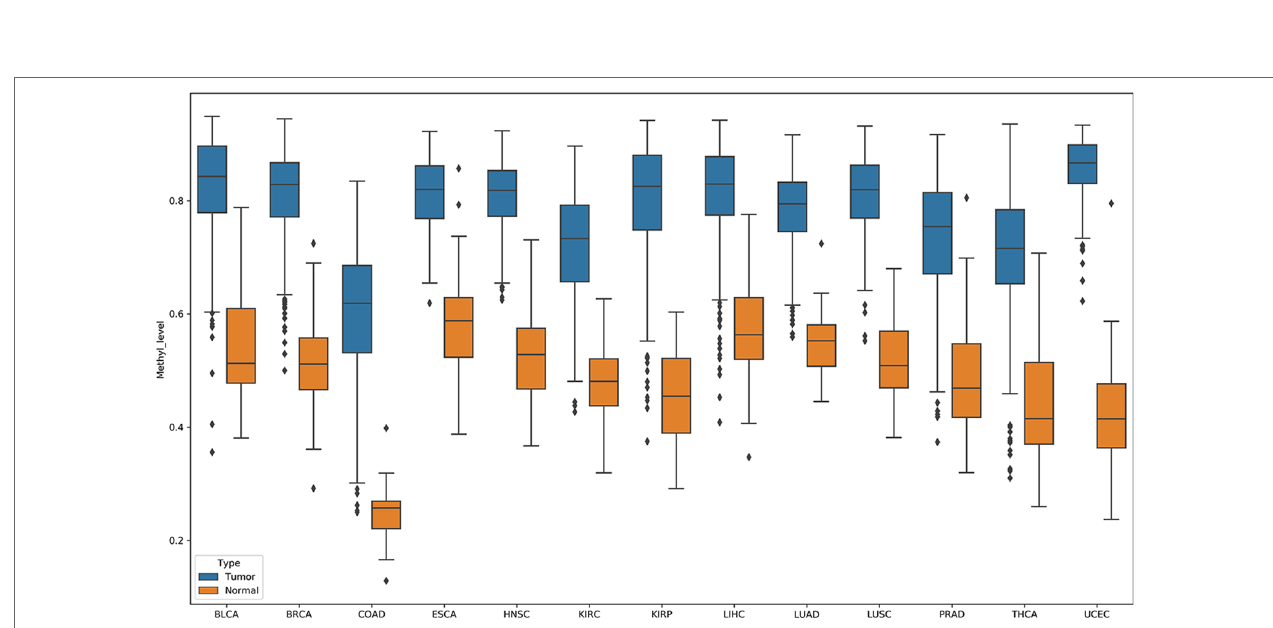
FIGURE 5 | Probe cg02829688 showed significant hypermethylation (the methylation level of loci in tumor samples were higher than those in normal samples) in all 13 cancers.